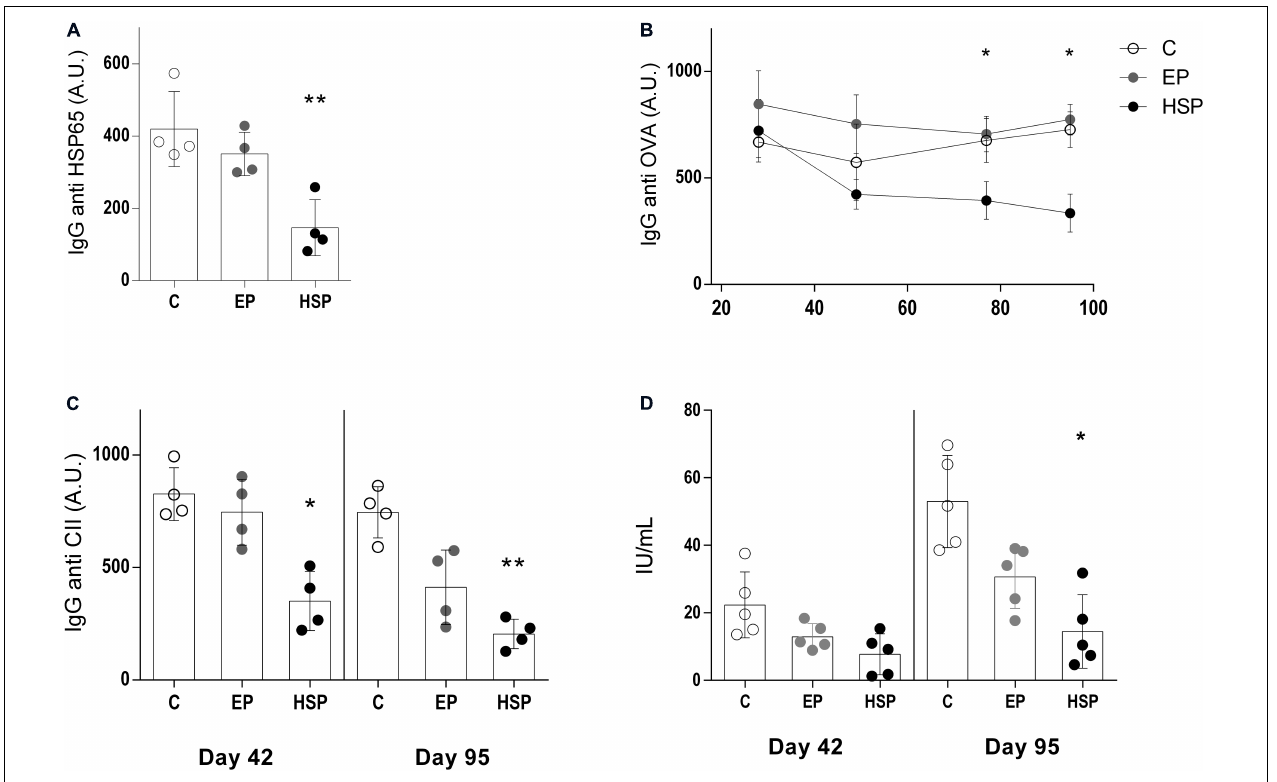
FIGURE 2 | Oral administration of Hsp65-producing L. lactis inhibited pathogenic serum antibodies. BALB/c mice were fed either XM17 broth only (C group), L. lactis -EP (EP group) or Hsp65-Lac (HSP group) for four days. Non-manipulated naïve animals were used to obtain basal levels (N group, dashed line). Ten days after treatment, arthritis was induced with four injections of CII+OVA in CFA. Sera were collected one week after each booster injection and at the end of the experiment (day 95). Graphs are representative of three independent experiments. (A) Levels of serum anti-HSP65 IgG, (B) anti-ovalbumin IgG, (C) anti-collagen IgG, and (D) rheumatoid factor were measured by ELISA. Values represent the mean ± SEM. * p < 0.05 compared to control C group. ** p < 0.005 compared to control C group. *** p <